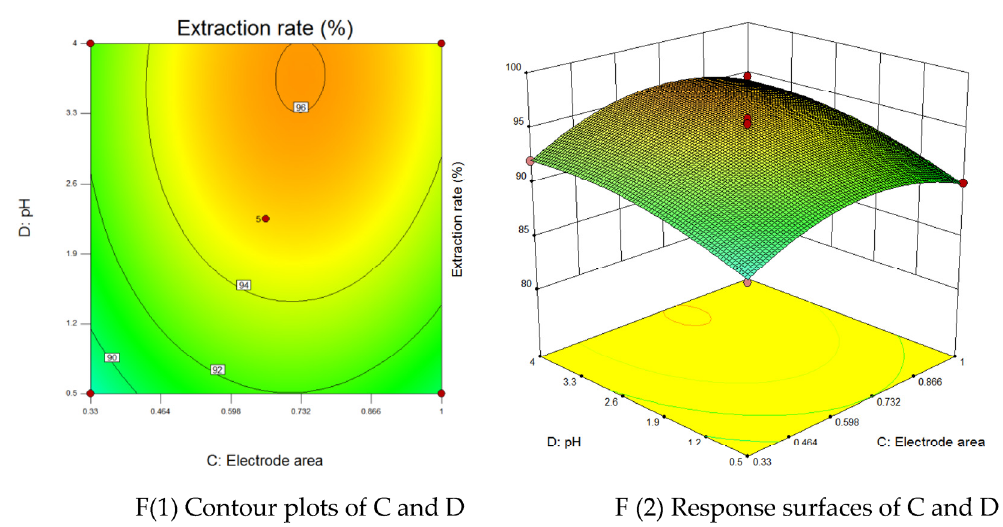
Figure 10. The contour map and response surface curve.